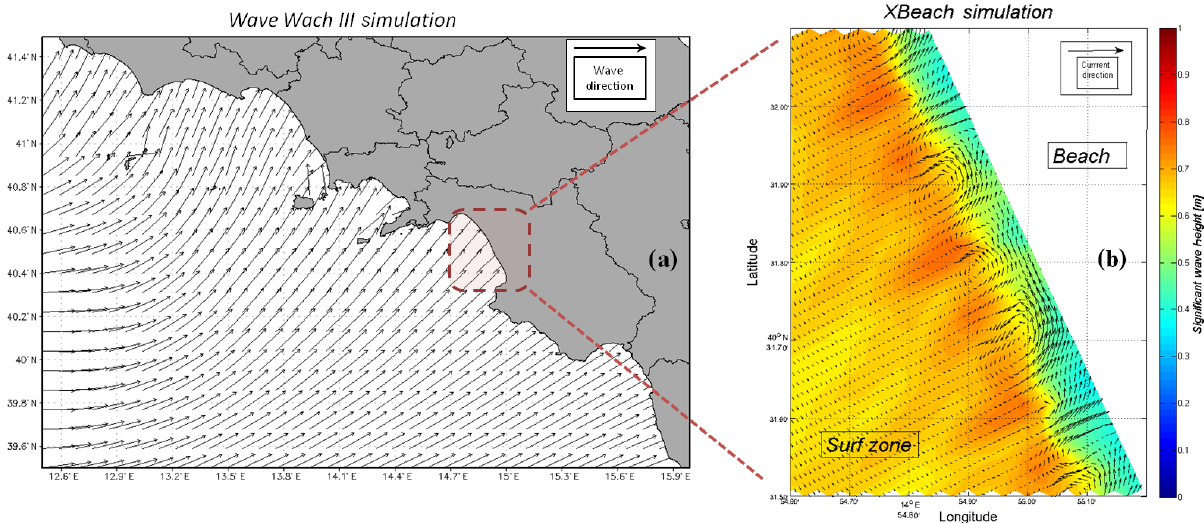
Figure 4. Offshore wave simulation associated with bathymetric survey of February 2008 with wave direction coming from WSW (a) . Hydrodynamic wave simulation giving rise to rip current formation (b) .